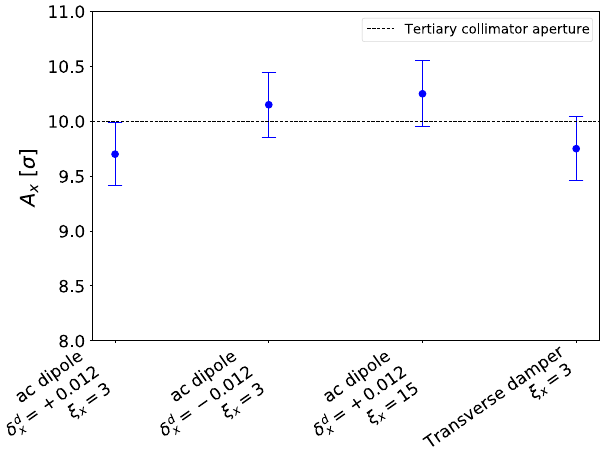
FIG. 11. Summary of horizontal aperture measurements per- formed in MD3 for beam 2 at injection optics and energy for different ac-dipole settings and beam